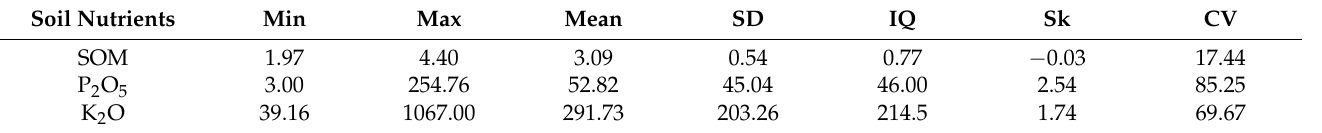
Table 3. Statistics of soil nutrients (SOM in %, available soil P 2 O 5, and K 2 O in ppm) in the study